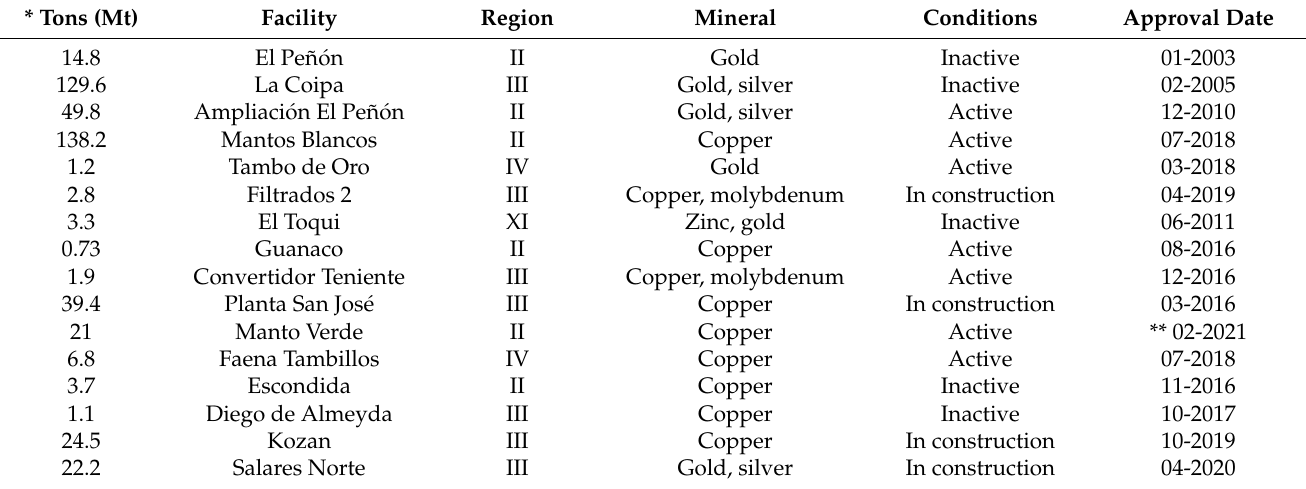
Table 1. Facilities with filtered tailings in